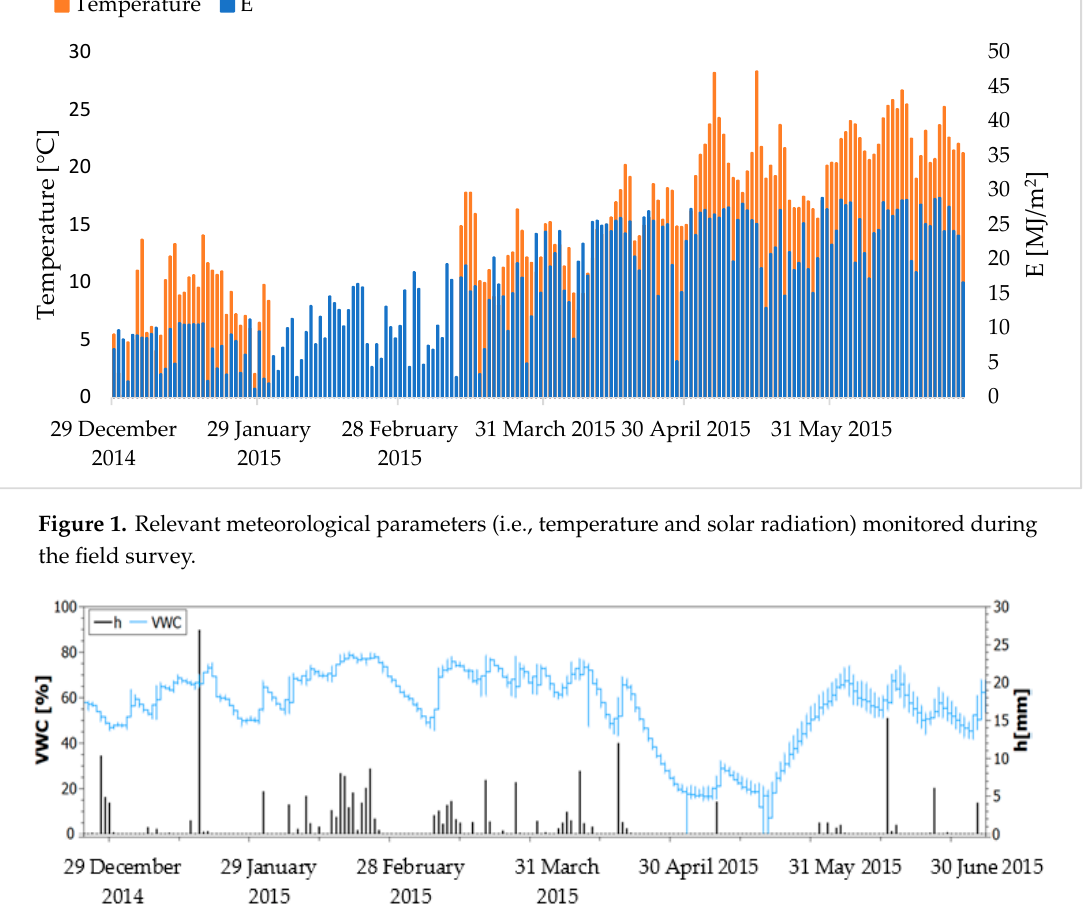
Figure 2. Normalized Volumetric Water Content (VWC) and precipitations monitored during the field survey.